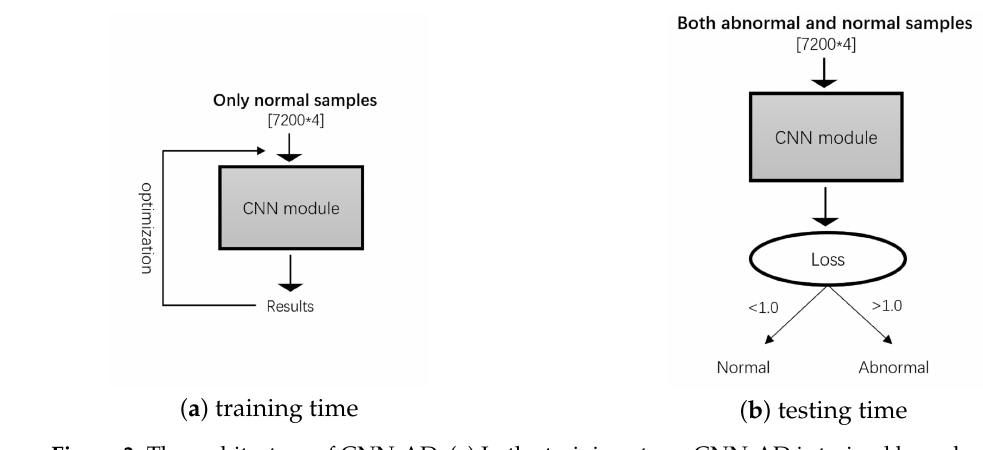
Figure 3. The architecture of CNN-AD. ( a ) In the training stage, CNN-AD is trained by only normal samples, the label is [1,0], then the cross entropy is calculated through the label and the output of the network, and Adam is used for network optimization. ( b ) In the test stage, CNN-AD divides the test set containing both normal and abnormal samples into two categories by